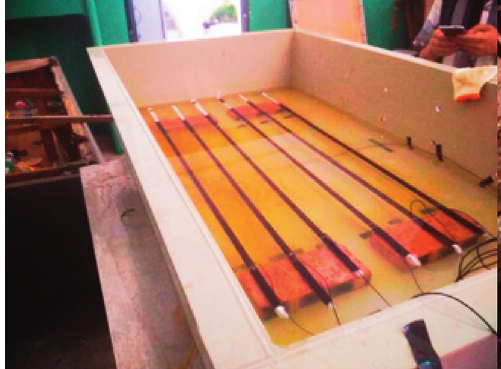
Figure 5: Corrosion diagram of steel strands.